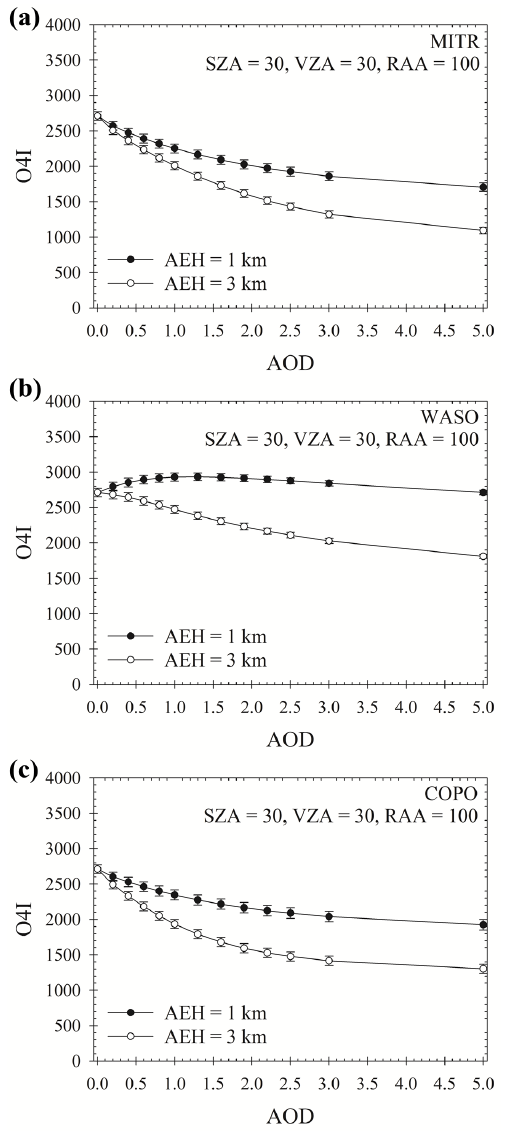
Figure 6. The O4I of (a) MITR, (b) WASO, and (c) COPO types as a function of AOD.